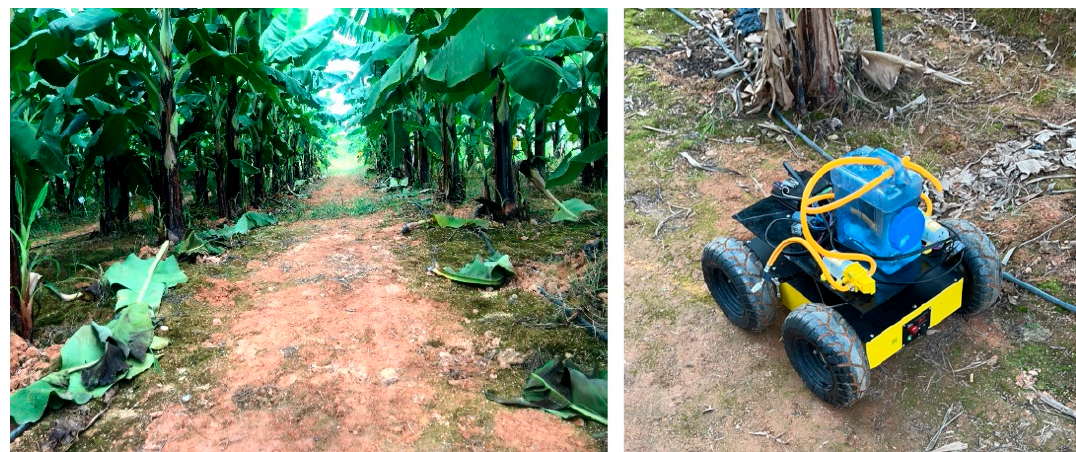
Figure 12. Spraying robot platform and the test environment.